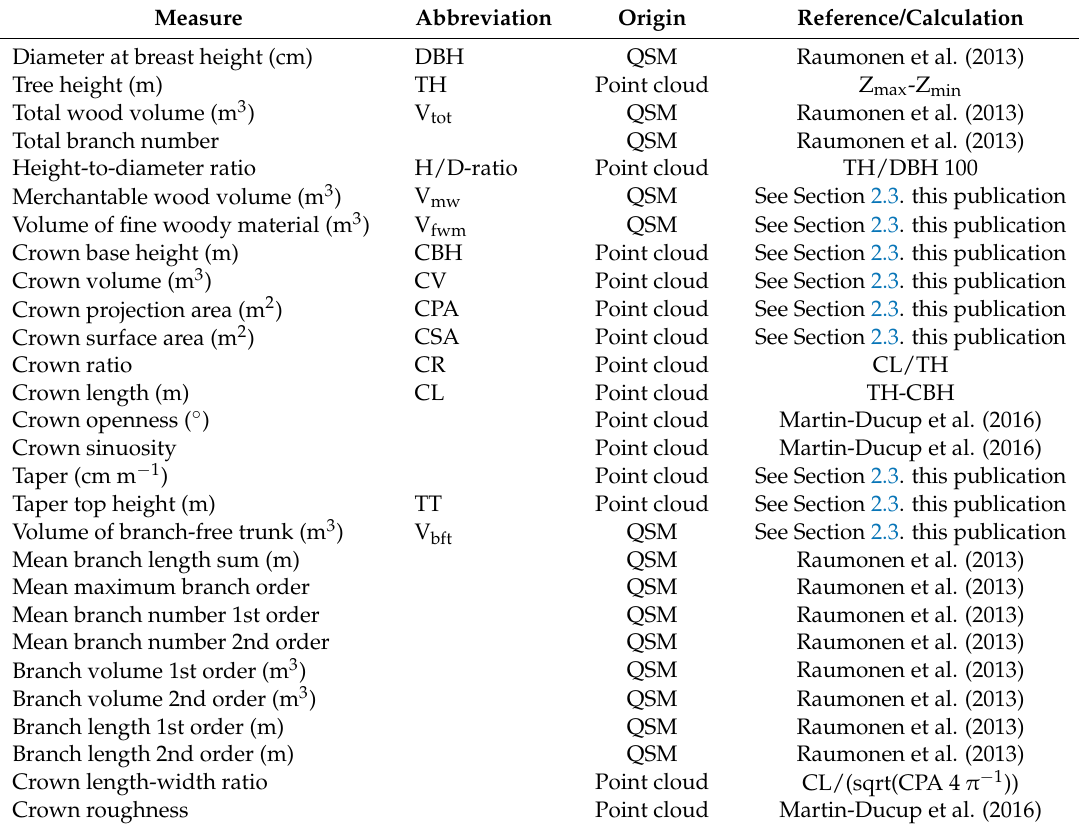
Table 2. Morphologic traits measured for each sample